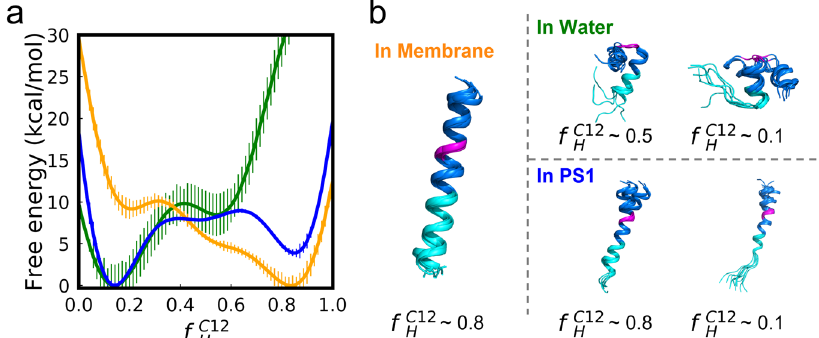
Fig. 2 The hydrophilic environment provided by PS1 favors the spontaneous unwinding of APP TMD. a Free energy pro fi les of unwinding as a function of residual helicity for the C12 region of the APP TMD, corresponding to APP TMD in membrane (orange), in water (green), and in the PS1 domain (blue). Uncertainty is estimated with block analysis. b Structural bundles of APP TMD in three simulation systems superimposed onto the middle of the APP TMD. Cyan: C12 region, last 12 residues on the C-terminal helix of APP TMD; magenta: Gly-Gly hinge in APP TMD. f C 12 H : the residual helicity of the C12 region.